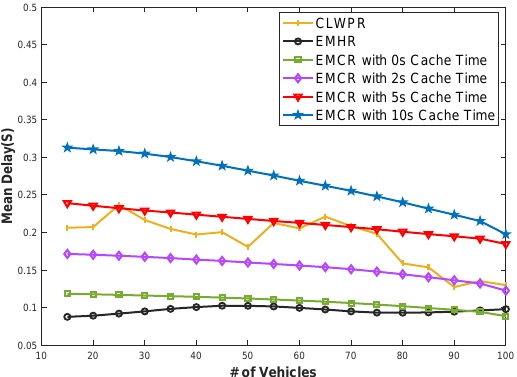
Figure 15. Average end-to-end delay vs. Number of Vehicles.